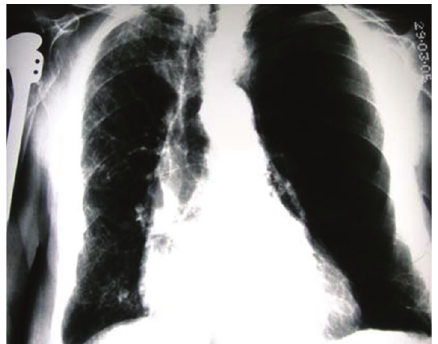
Figure 10: A CXR on a patient with COPD that had undergone a recent shoulder arthroplasty presented with acute shortness of breath. Diagnosis of left-sided pneumothorax was made clinically and from the CXR. A question of bullous emphysema was raised so an urgent CT scan was arranged. See Figure 12.